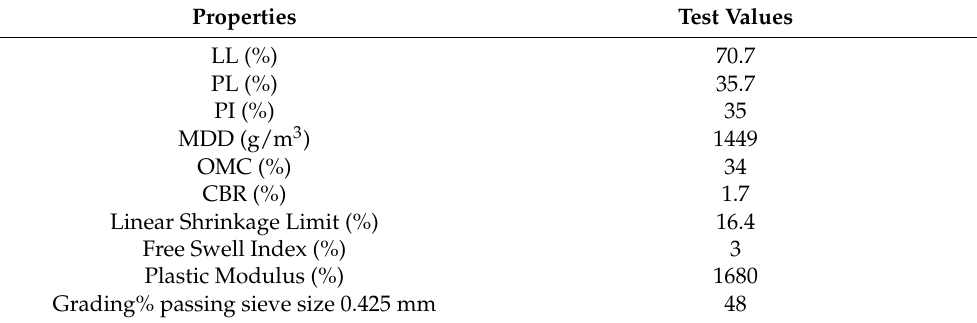
Table 1. Engineering properties of BCS.